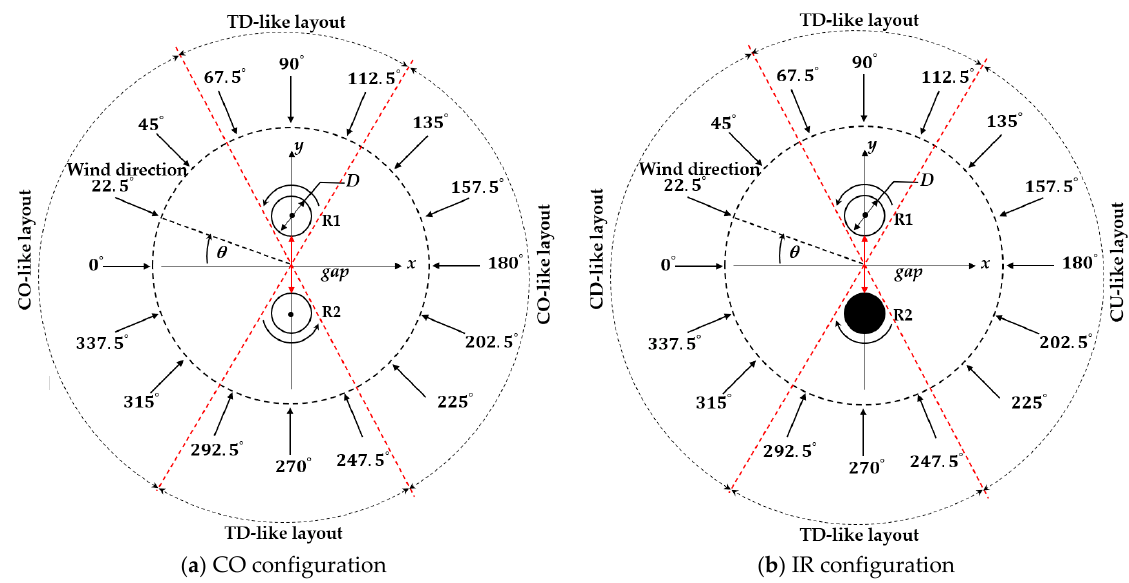
Figure 10. Definition of 16 wind directions in the two configurations in the case of paired rotors: ( a ) co-rotation (CO) configuration; ( b ) inverse rotation (IR) configuration.